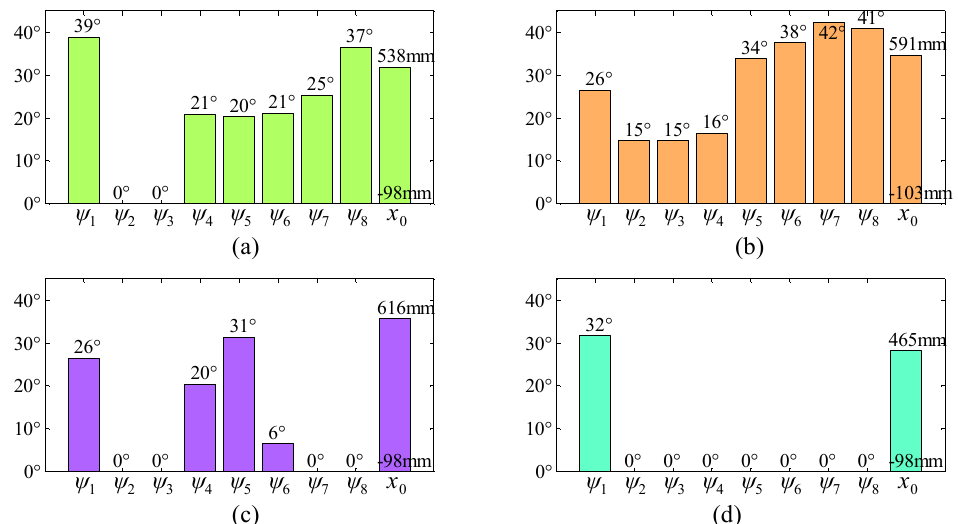
Figure 16. Histogram of the corresponding variation ranges of ψ i and x 0 in four environments. ( a ) The range of ψ i and x 0 in obs1; ( b ) The range of ψ i and x 0 in obs2; ( c ) The range of ψ i and x 0 in obs3; ( d ) The range of ψ i and x 0 without obstacles.